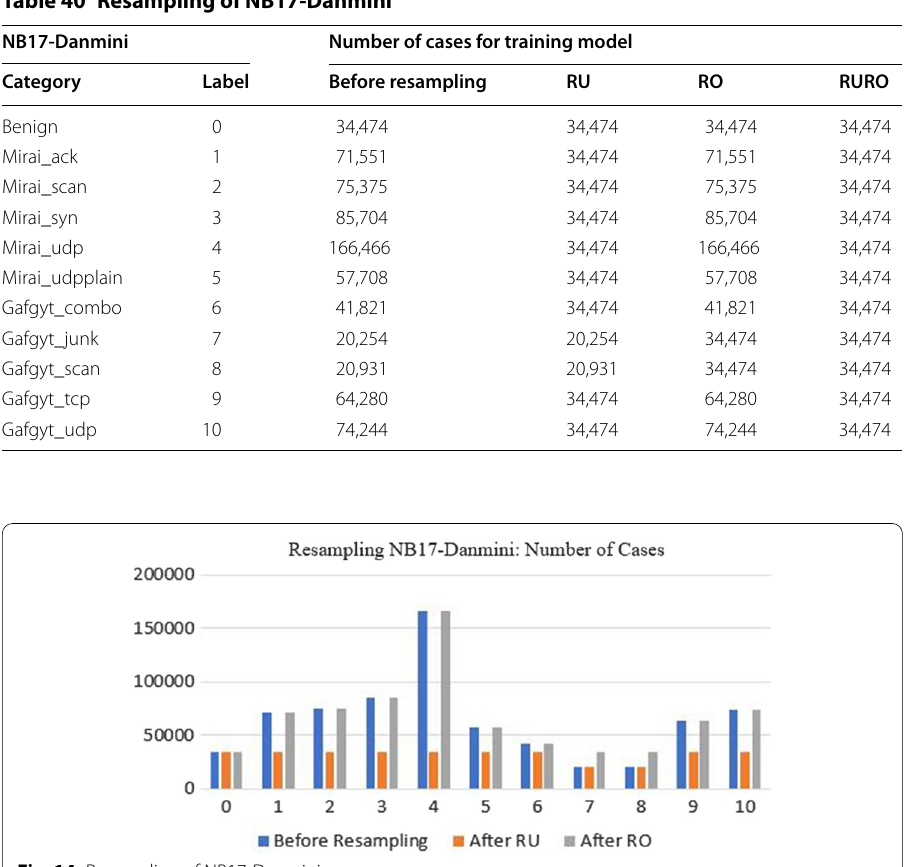
Table 40 Resampling of NB17-Danmini